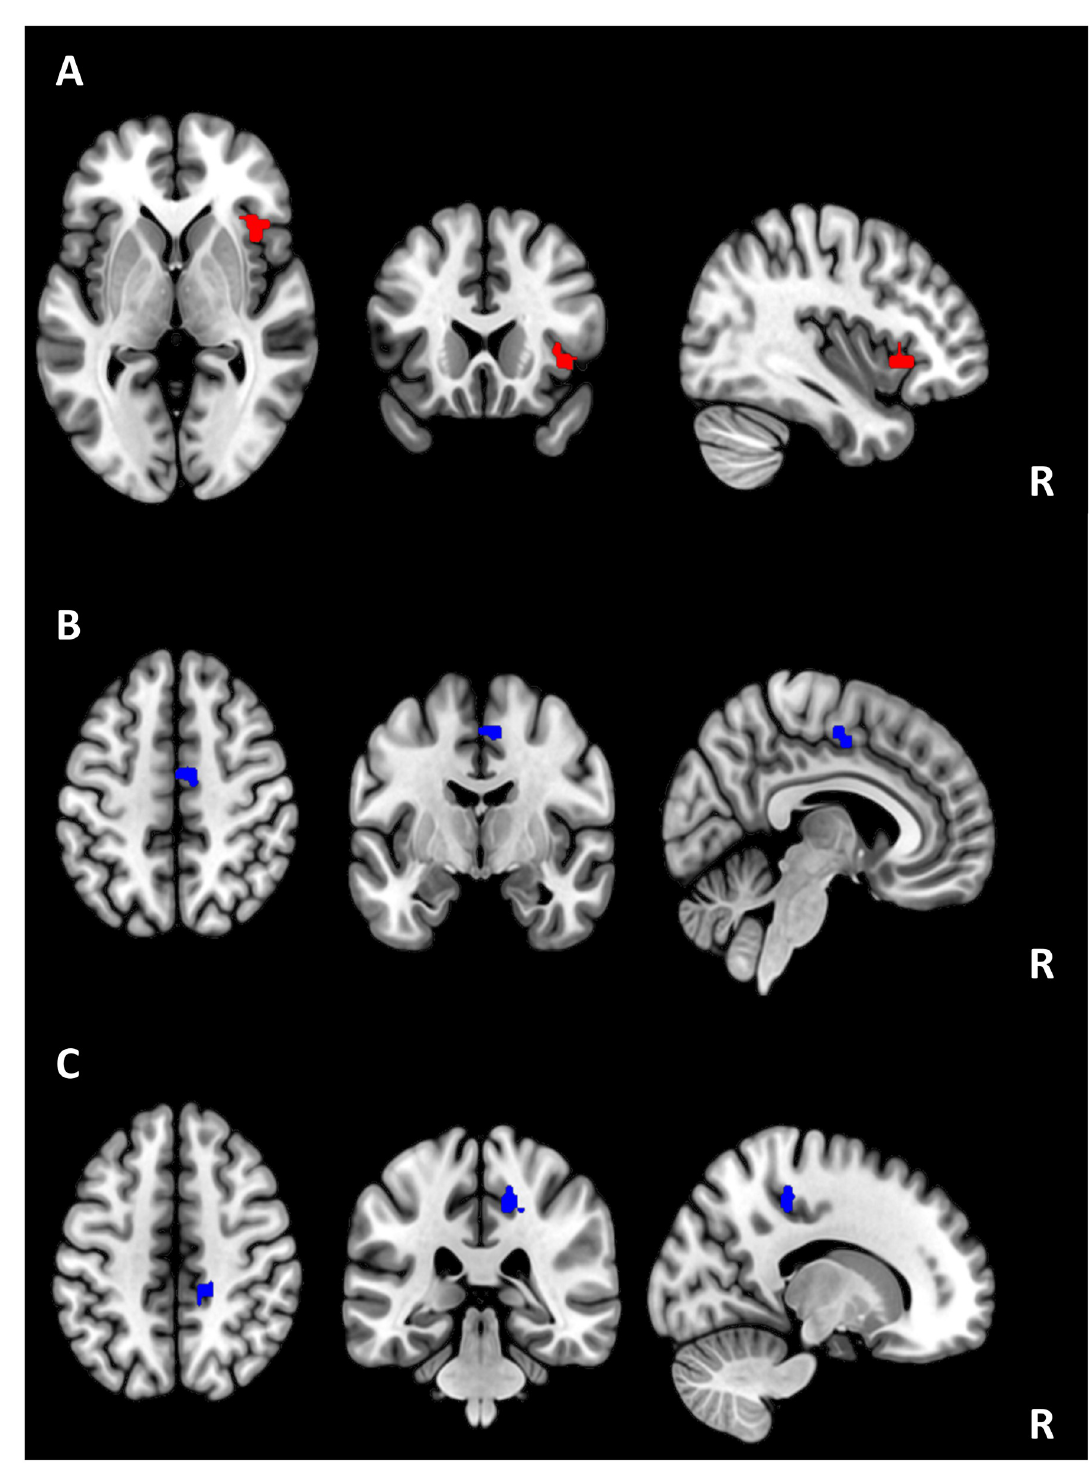
Fig 3. Associations between ISAm-total, ISAm-LID and resting-state fMRI functional connectivity. A) Positive association between ISAm-total scores and functional connectivity between the left IFG seed and the insular cortex. B) Negative association between ISAm-LID scores and functional connectivity between the left IFG seed and the supplementary motor area. C) Negative association between ISAm-LID scores and functional connectivity in between the right IFG seed and the precentral gyrus. All results were corrected for multiple comparisons using family-wise error (FWE) correction at cluster level. Abbreviations: ACC, anterior cingulate cortex; IFG, inferior frontal gyrus. https://doi.org/10.1371/journal.pone.0279722.g003 PLOS ONE | https://doi.org/10.1371/journal.pone.0279722 February 24,